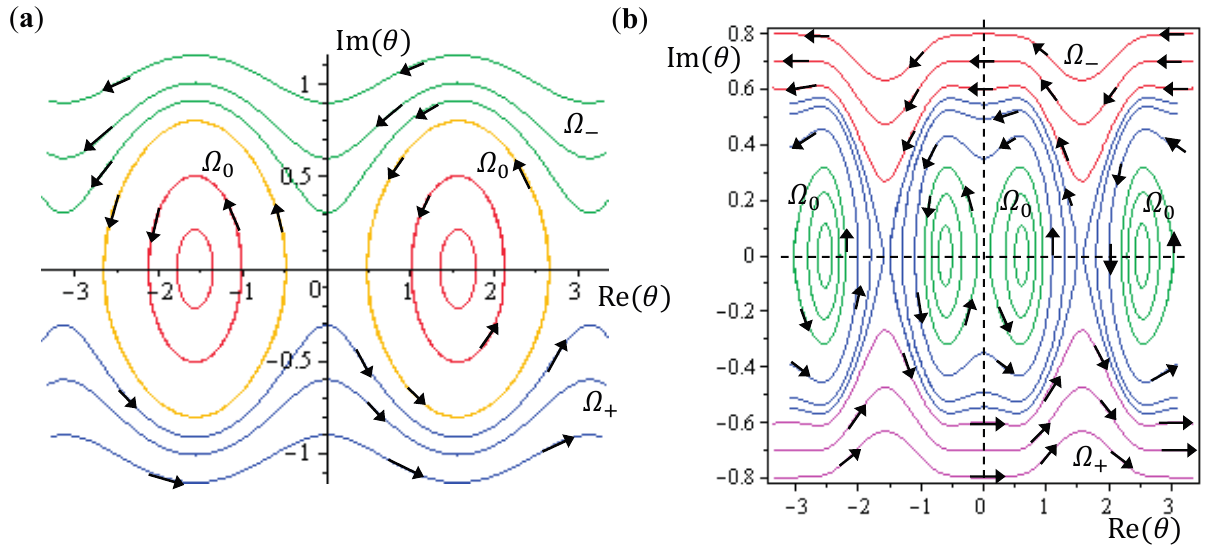
/(cid:1856)(cid:2028) < 0 , the central region Ω (cid:3019) /(cid:1856)(cid:2028) > 0 (cid:3019)